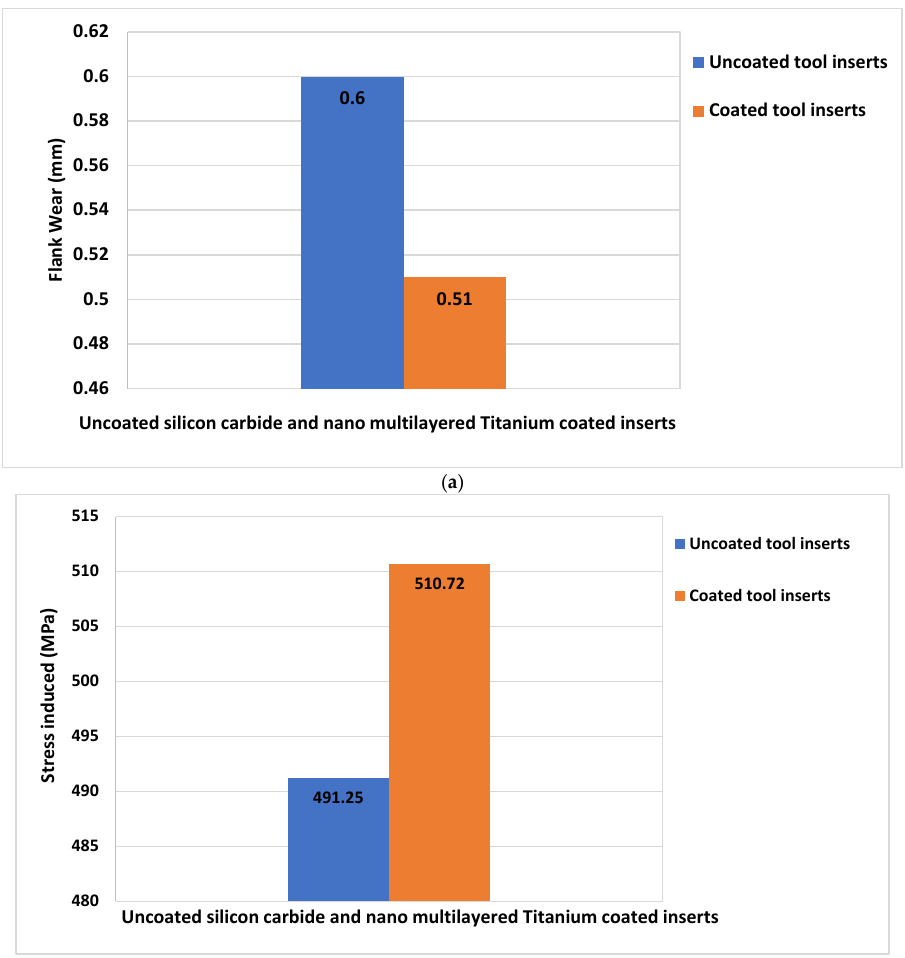
Figure 7. Flank wear and stress characteristics for uncoated and TiN-coated inserts. ( a ) Reduction of flank-wear for uncoated Silicon Carbide and Nano multilayered Titanium tool inserts. ( b ) Improvement of cutting tool stress for uncoated and Nano multilayered Titanium-coated inserts.